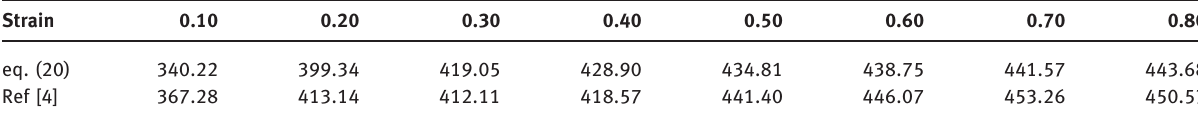
Table 2: The values of Q (kJ·mol − 1 ) at various strain. Strain  . 